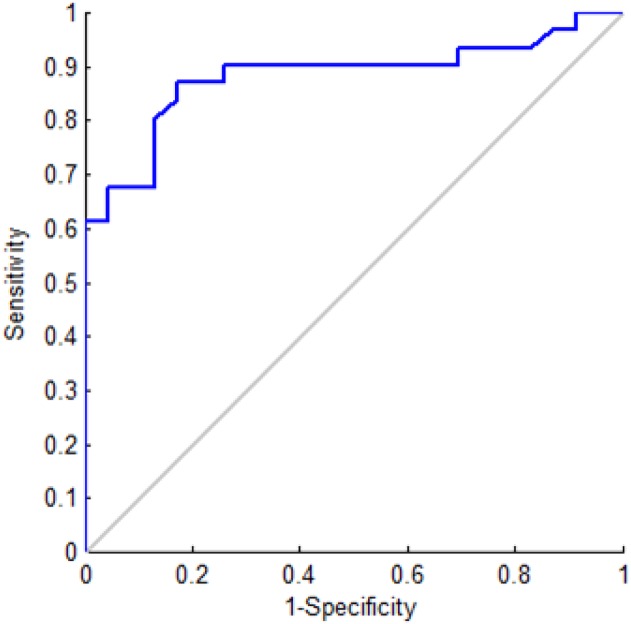
ROC curve of the CUSE imaging technique.The diagonal line is the line of no-discrimination.